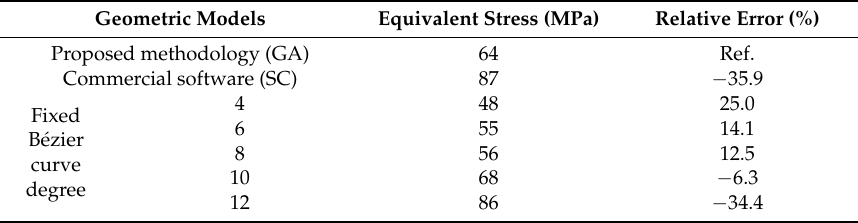
Table 2. Stresses and relative errors obtained by the Finite Element Analysis (FEA) for the different methods used.